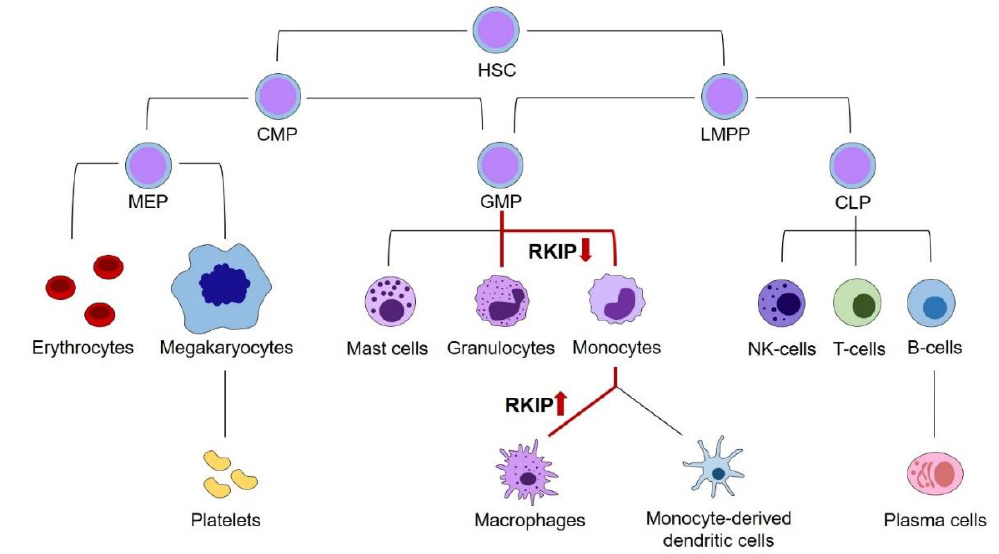
Figure 1. The role of RKIP in physiologic hematopoiesis. Schematic presentation of hematopoiesis. A decrease of RKIP expression occurs at the GMP stage and is an important step in monocyte and granulocyte di ff erentiation. However, in a physiologic setting, the decreased expression in these cells is not irreversible and resurgence seems to be an essential step in the terminal di ff erentiation of monocytes into macrophages. Changes in RKIP expression are highlighted by red arrows. HSC, hematopoietic stem cells; CMP, common myeloid progenitors; LMPP, lymphoid-primed multipotential progenitors; CLP, common lymphoid progenitors; GMP, granulocyte–monocyte progenitors; MEP, megakaryocyte–erythrocyte